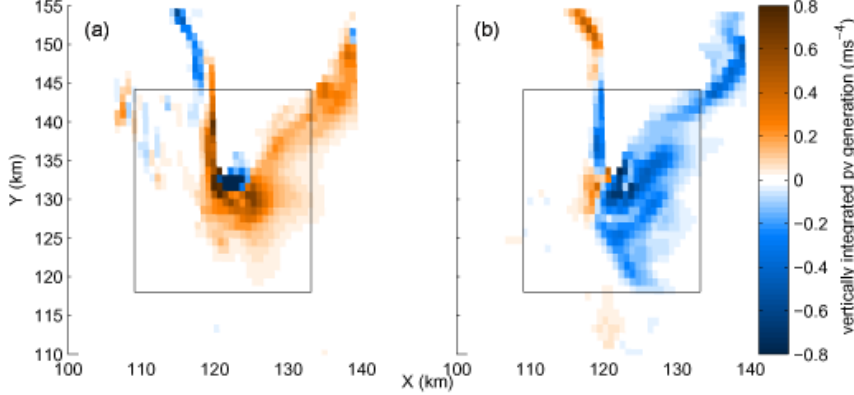
Fig. 11. Vertically integrated PV generation near the cape during (a) peak flood and (b) peak ebb tides.